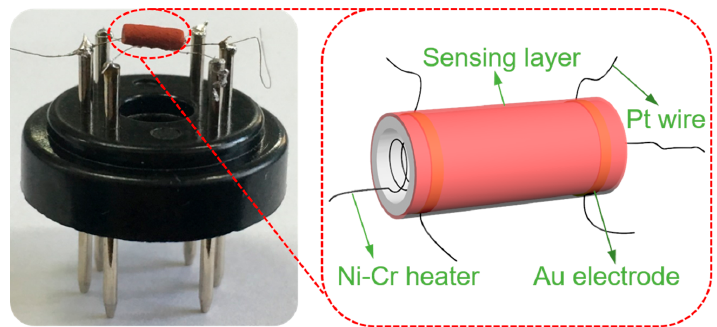
Figure 2. Structure schematic of a typical gas sensor.